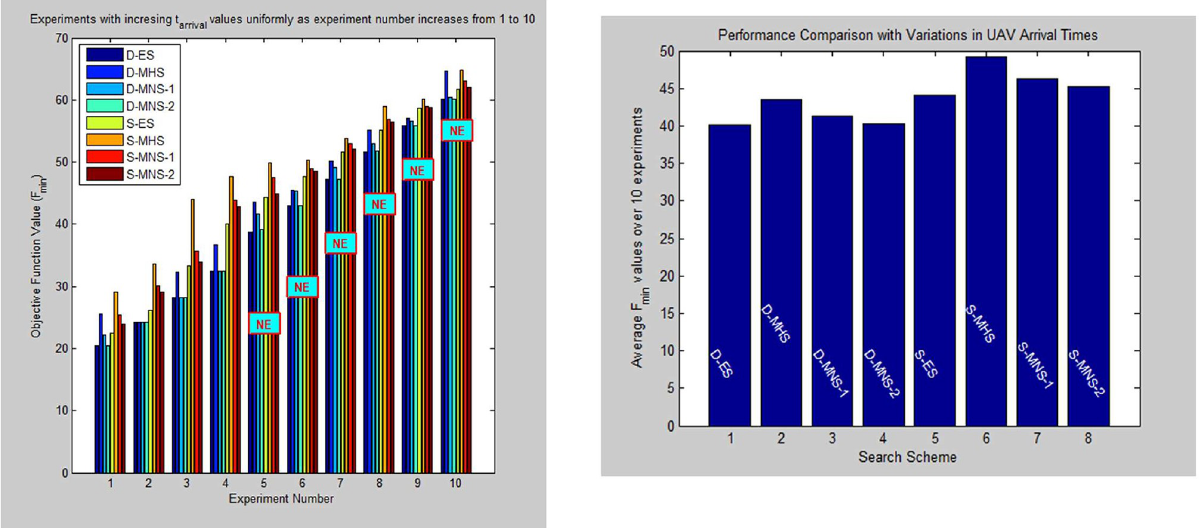
Fig 8. (a) F and success/failure results. UAV time of arrival t min Performance comparison in terms of average F min values for experiments involving time of arrival